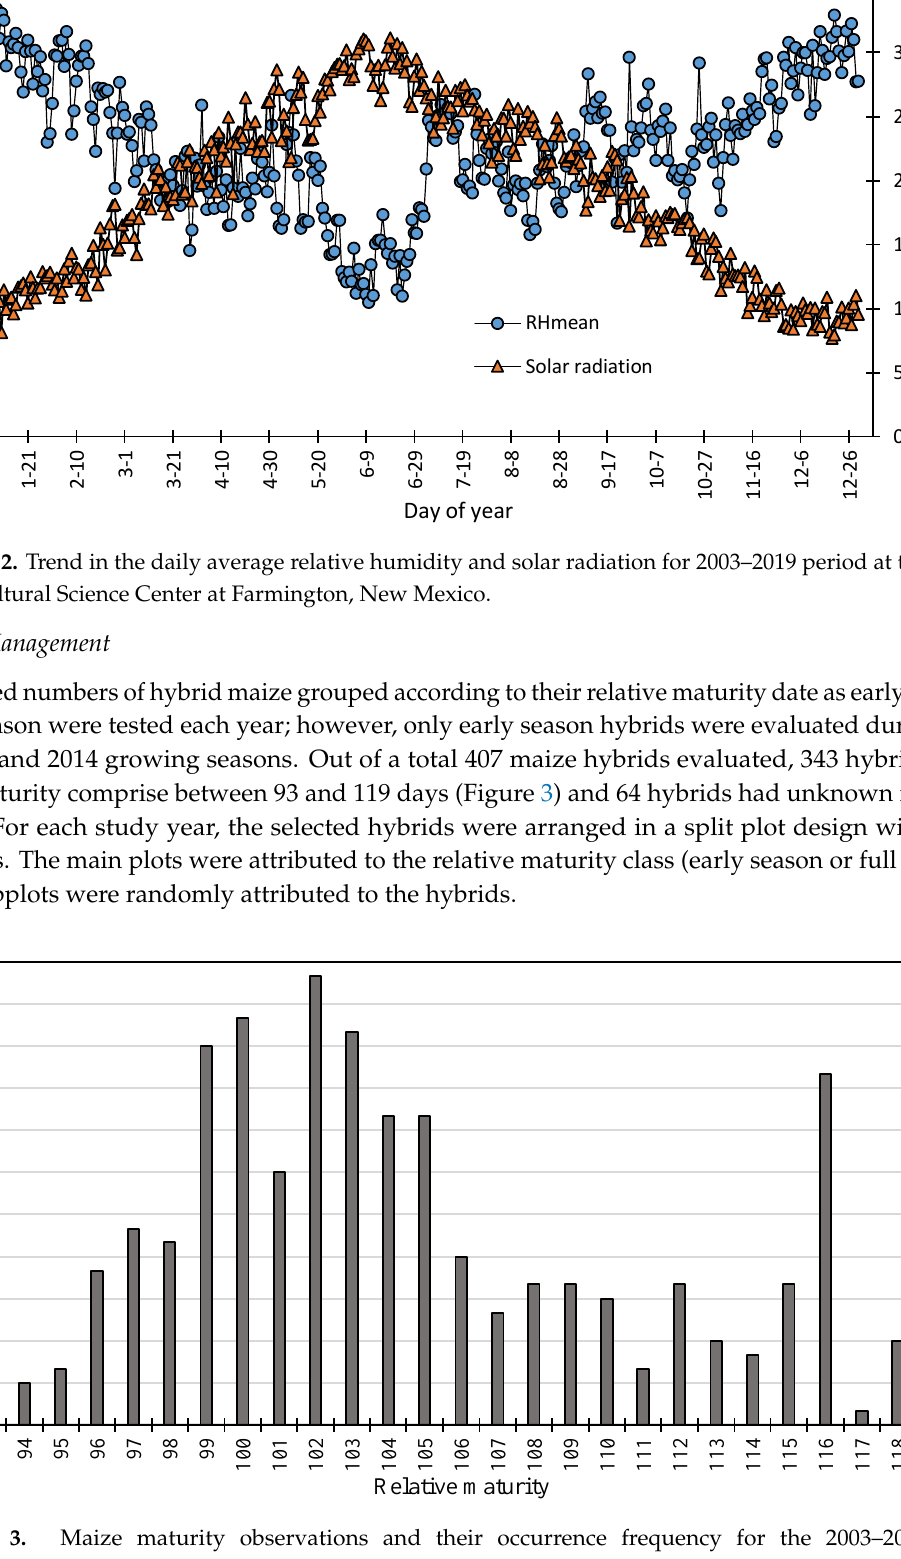
Figure 1. Trend in the daily average mean, maximum and minimum temperatures for 2003 – 2019 period at the Agricultural Science Center at Farmington, New Mexico.